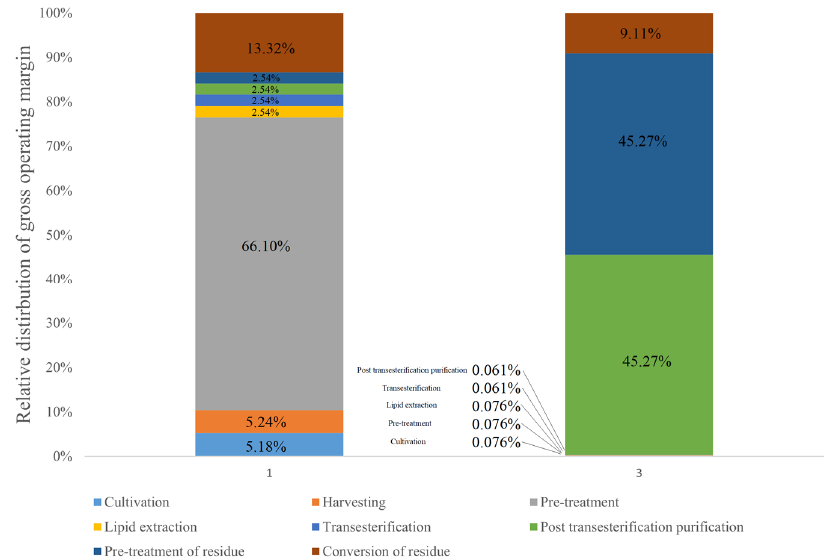
Figure 7. Distributions of stage-wise gross operating margin for two scenarios.